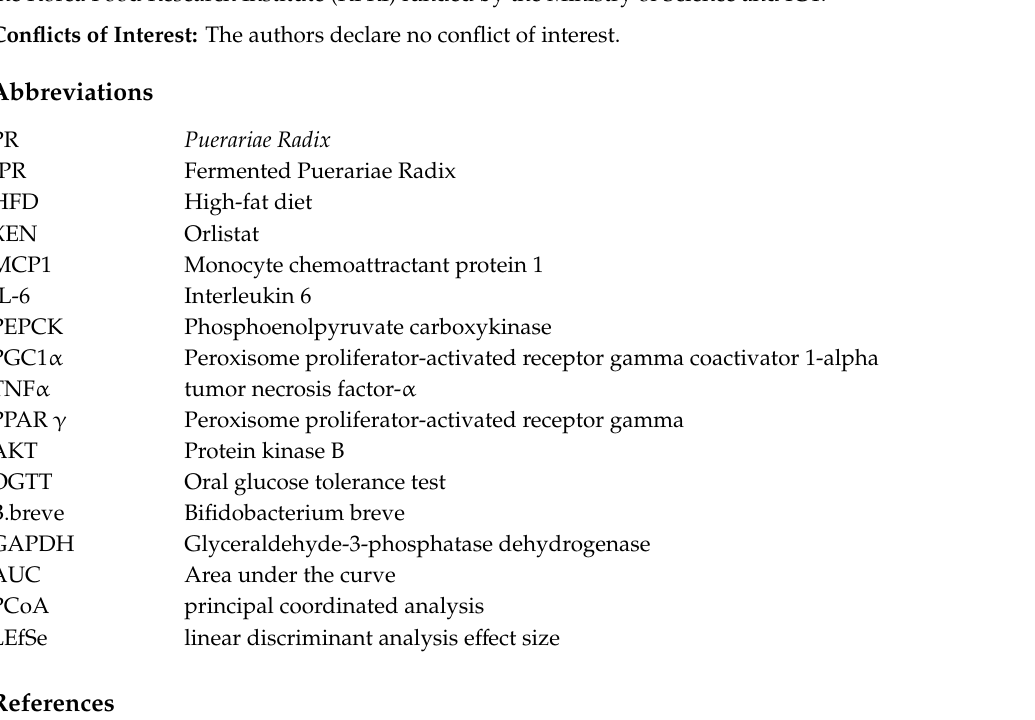
Figure S1: HPLC calibration curve of the organic acid standards; Figure S2: (A) Alpha-diversity, measured